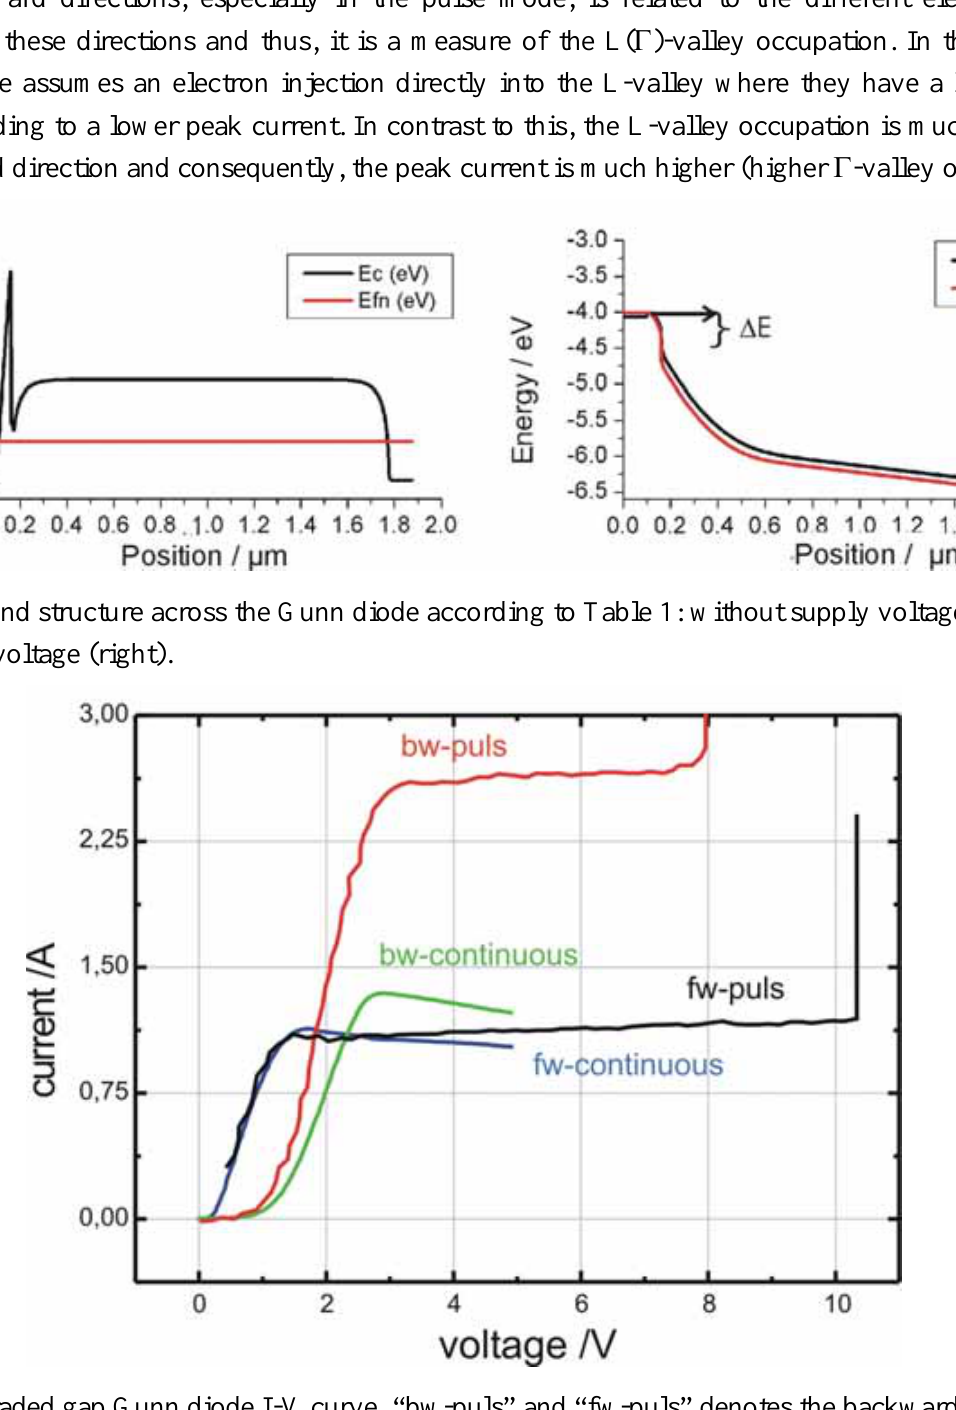
Figure 8. Graded gap Gunn diode I-V curve, “bw-puls” and “fw-puls” denotes the backward- (bw) and forward- (fw) directions measured in the 100 ns pulse mode, “bw-continuous” and “fw-continuous” denotes the backward- and forward- directions measured in the continuous